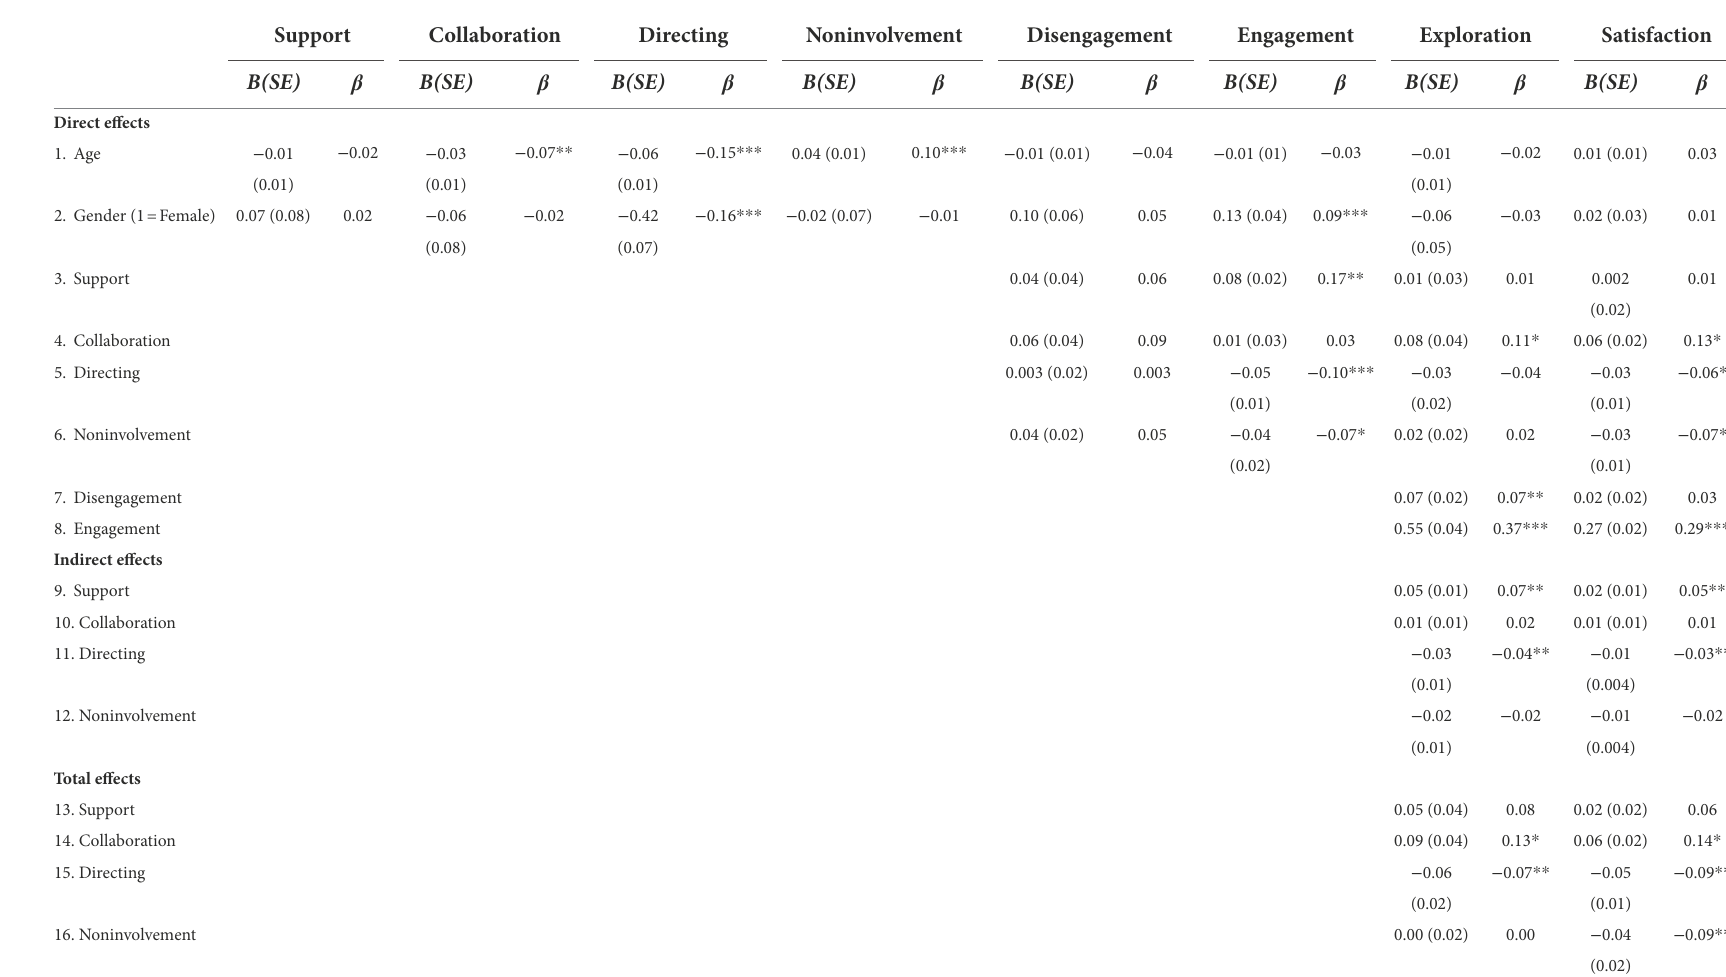
TABLE 4 Direct, indirect, and total effects of shared and nonshared agency from fathers on occupational